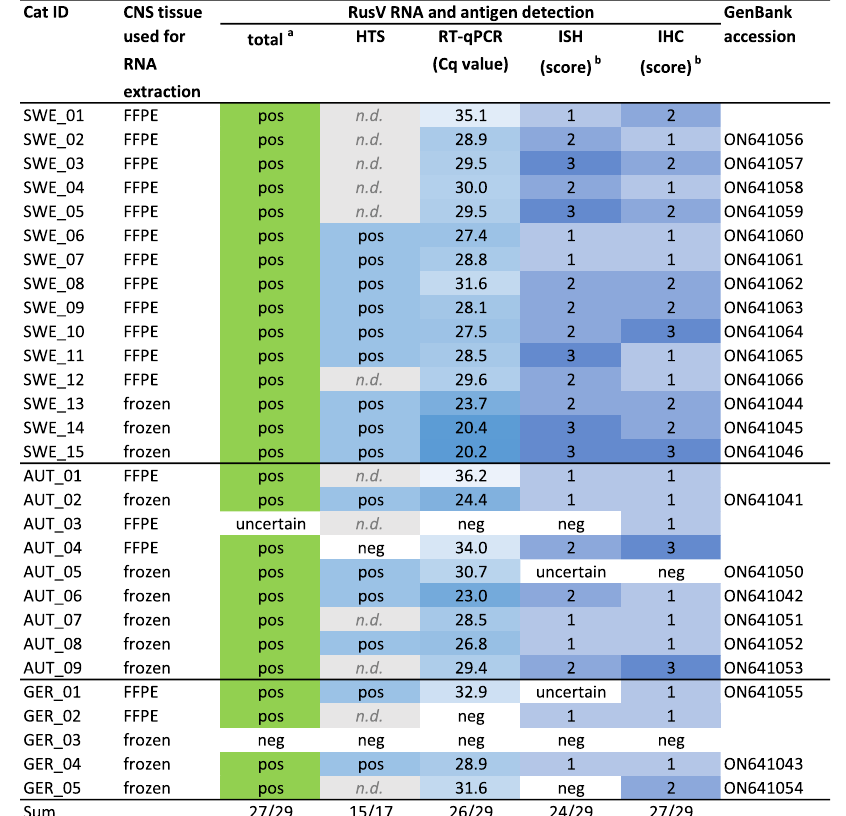
Fig. 2 | Detection of rustrela virus (RusV) RNA and antigen in cats with ‘ stag- gering disease ’ . Cats with clinical signs and histopathological lesions consistent with the criteria of ‘ staggering disease ’ were tested by different independent diagnostic methods. Cats were considered RusV-positive if RusV RNA and/or anti- gen was detected by at least two of the applied methods (RT-qPCR, ISH, IHC, sequencingbyHTS).Catswithapositiveresultinonlyoneassaywereconsideredas uncertain. Green indicates an overall positive result of an individual, whereas blue